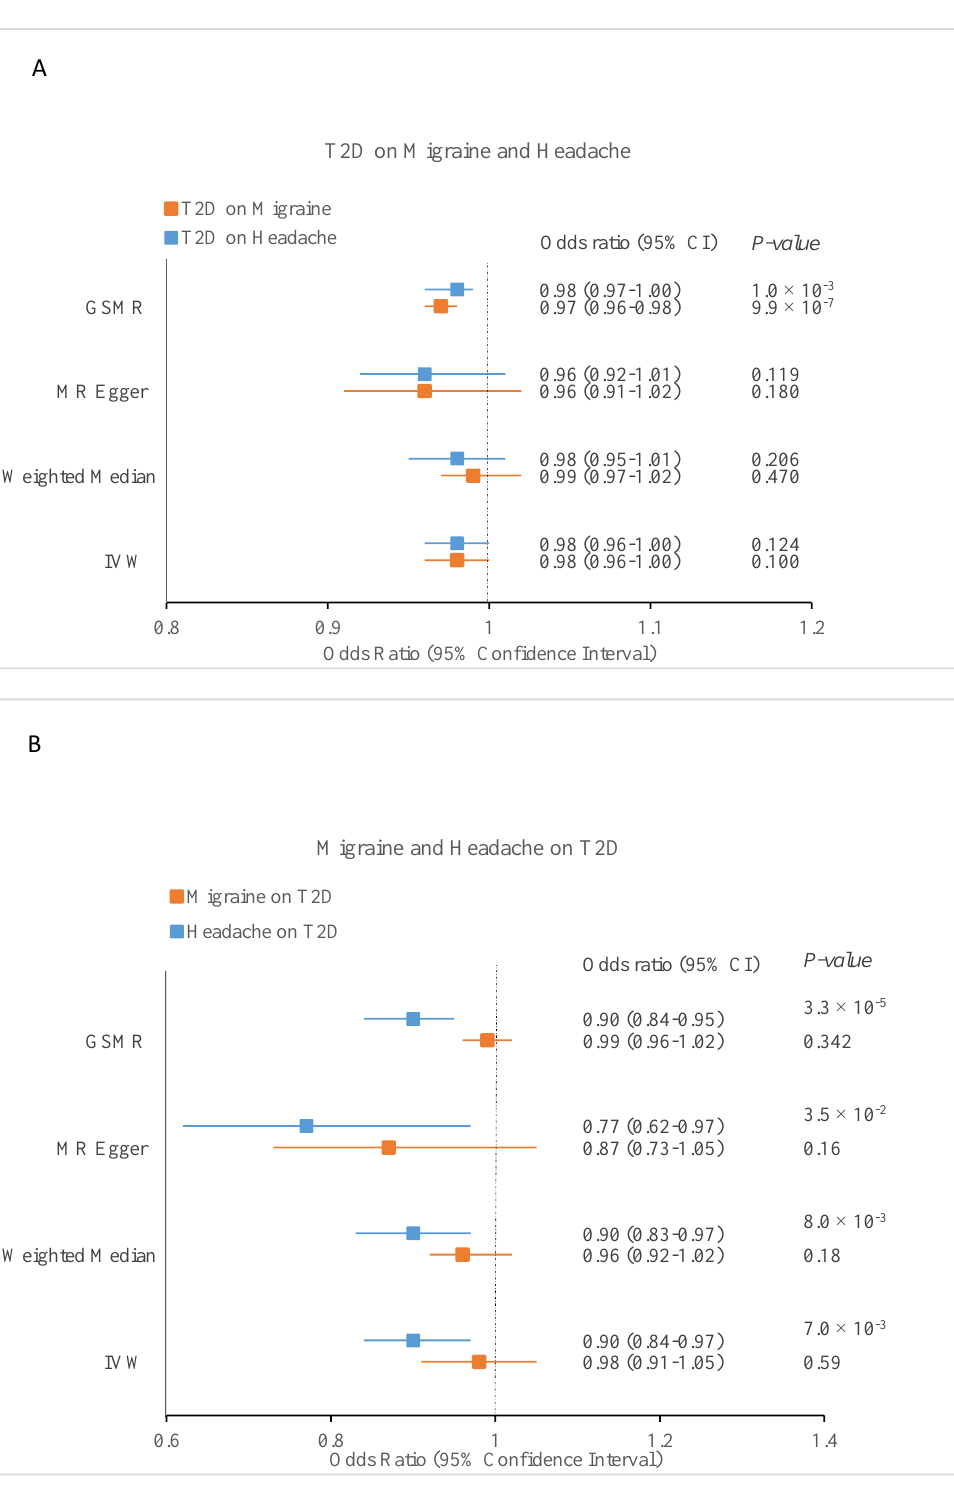
Figure 3. The forest plot presents ORs and 95% CIs for MR analyses testing genetic predisposition to T2D on migraine and headache ( A ), and genetic predisposition to migraine and headache on T2D ( B ). IVW: Inverse variance weighted, GSMR: Generalised summary data-based Mendelian Randomisation, T2D: Type 2 Diabetes.